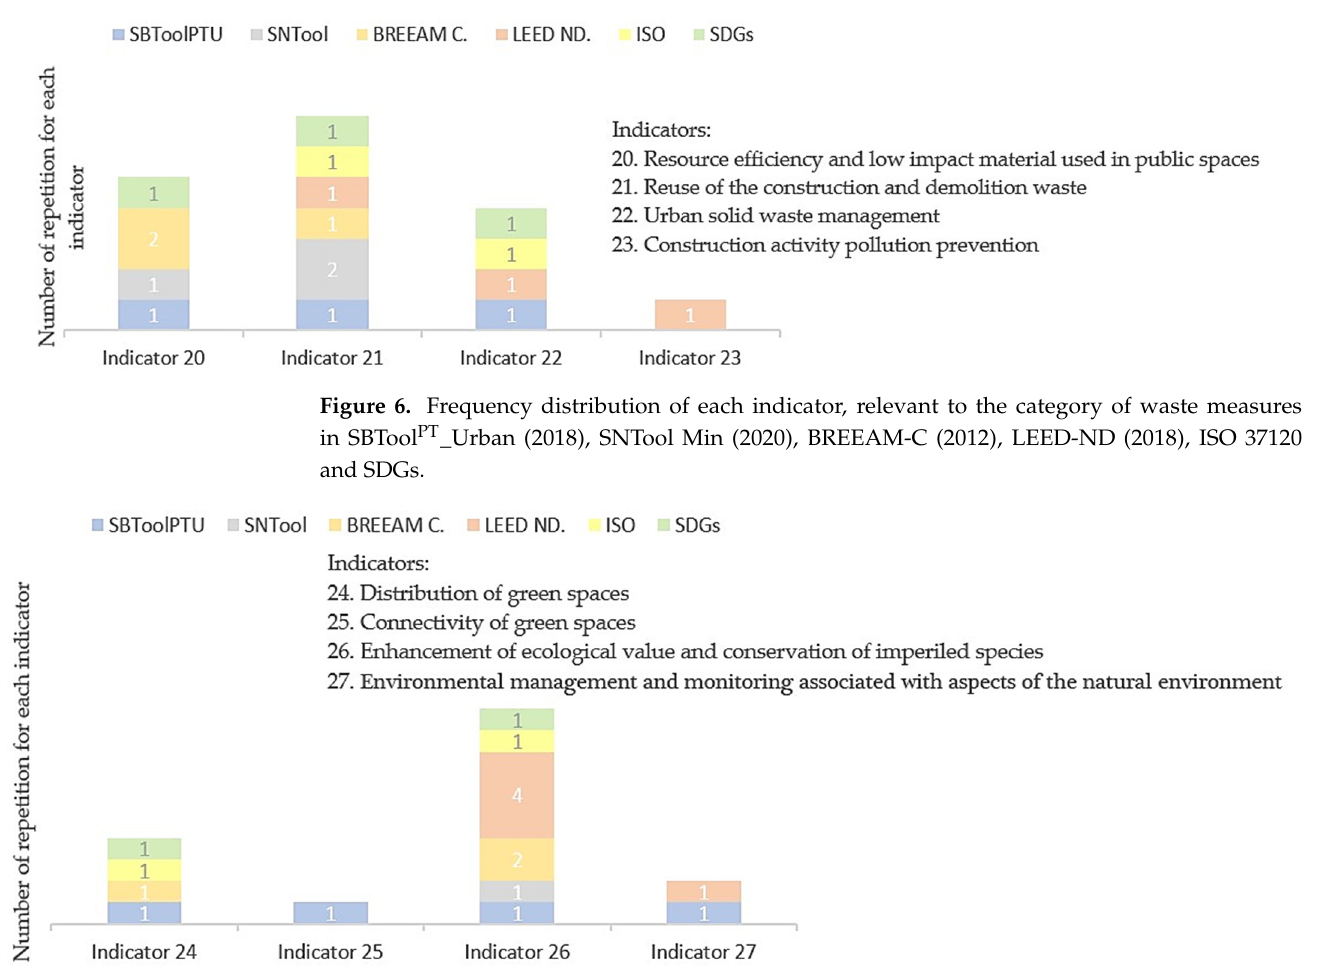
Figure 7. Frequency distribution of each indicator, relevant to the category of ecosystems and landscapes in SBTool PT _Urban (2018), SNTool Min (2020), BREEAM-C (2012), LEED-ND (2018), ISO 37120, and SDGs.